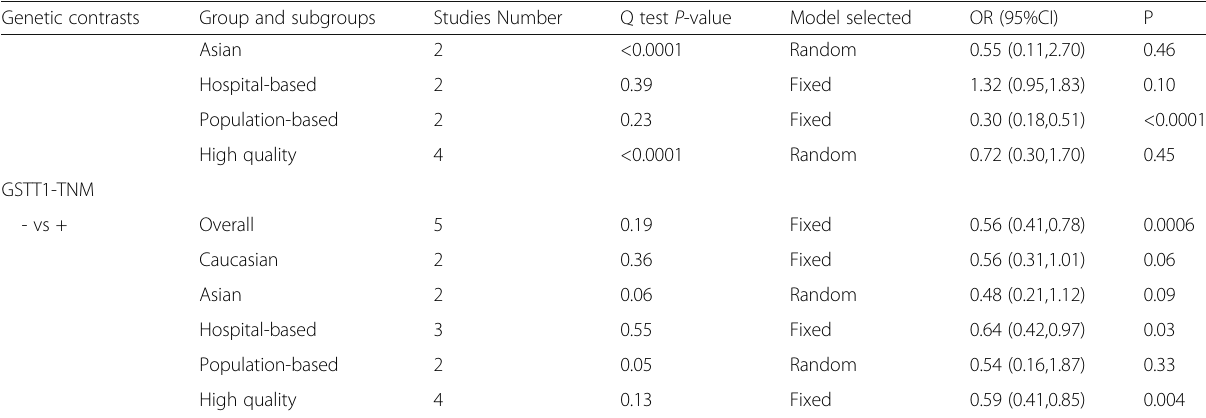
Table 4 Meta-analysis of the association of GSTM1- and GSTT1-null genotypes and GSTP1 with RCC risk and the relationship between GSTM1, GSTT1 and clinical TNM stages of RCC (Continued) Genetic contrasts